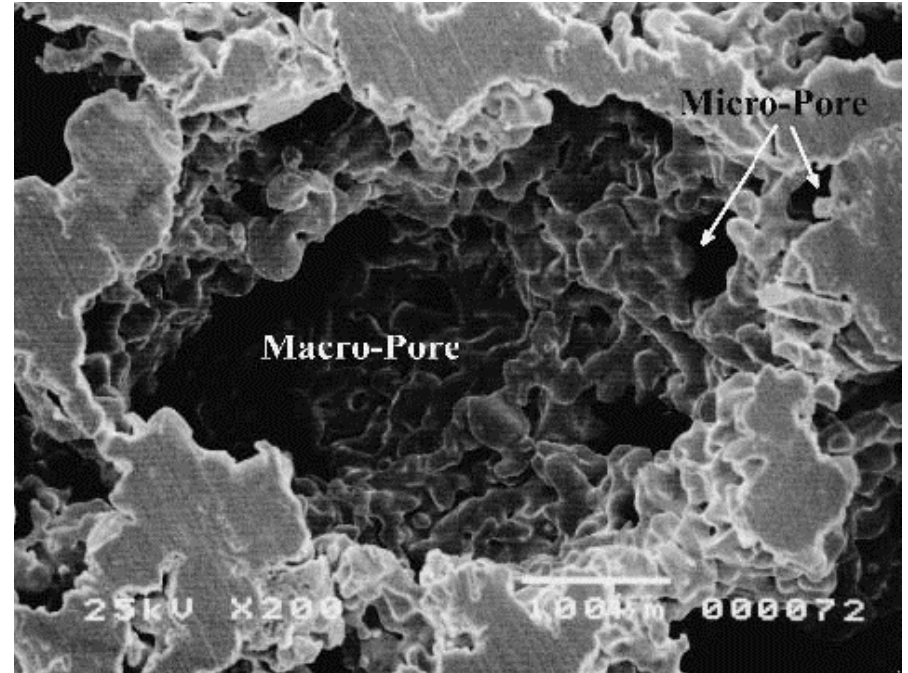
Figure 19. Scanning electron microscopy (SEM) micrograph of porous titanium with a relative density of 0.30 fabricated using space holder method [48]. Reprinted with permission from [48]. Copyright 2002 Cambridge University